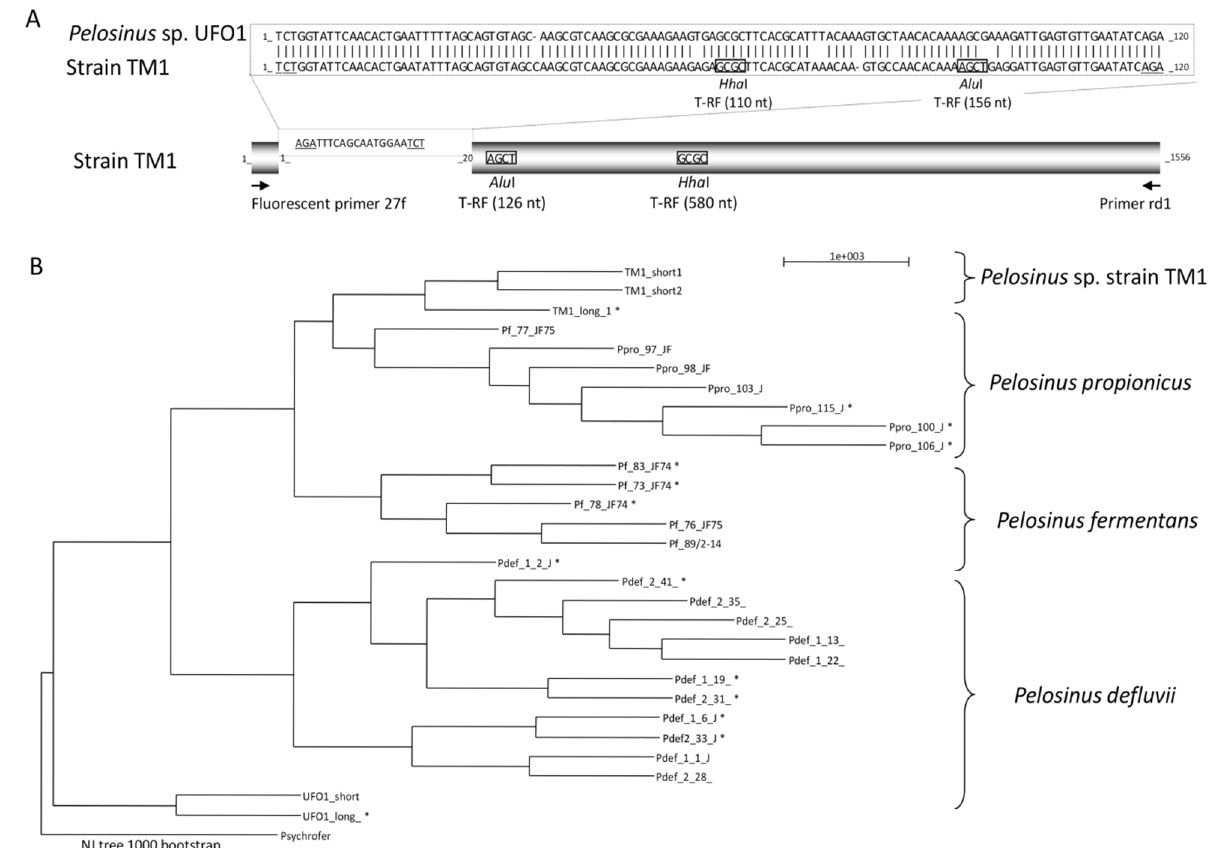
Figure 2. Taxonomic affiliation and 16S rRNA gene heterogeneity of strain